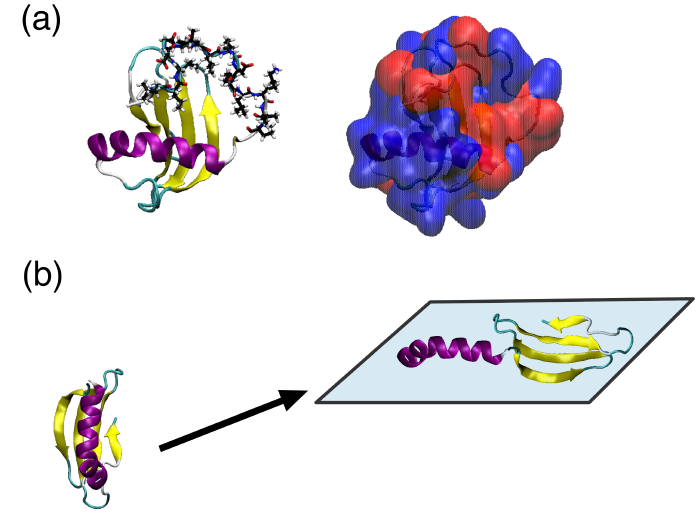
Figure 4. ( a ) structure of Rsn-2 with in cartoon ( left ) and surface ( right ) representations. In cartoon representation, the hydrophobic N-terminus loop is highlighted. On the surface representation, blue and red denote hydrophilic and hydrophobic regions, created using PDB code 2WGO; ( b ) illustration of Rsn-2 opening transition during interfacial